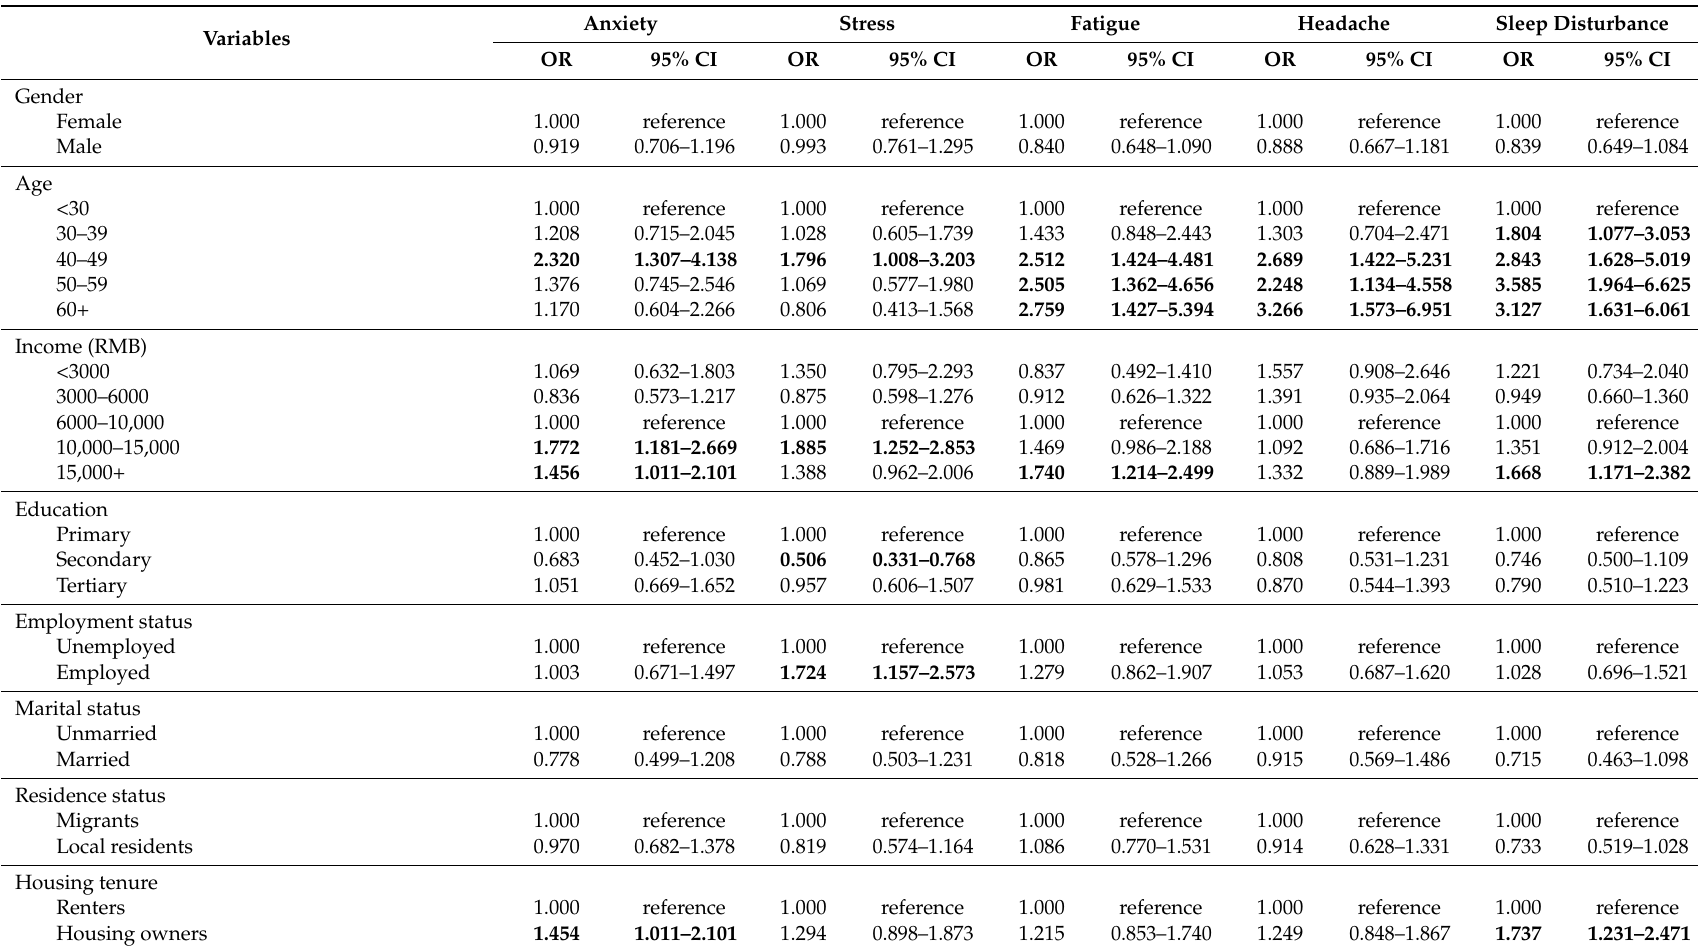
Table 3. Multilevel modeling results for five types of mental